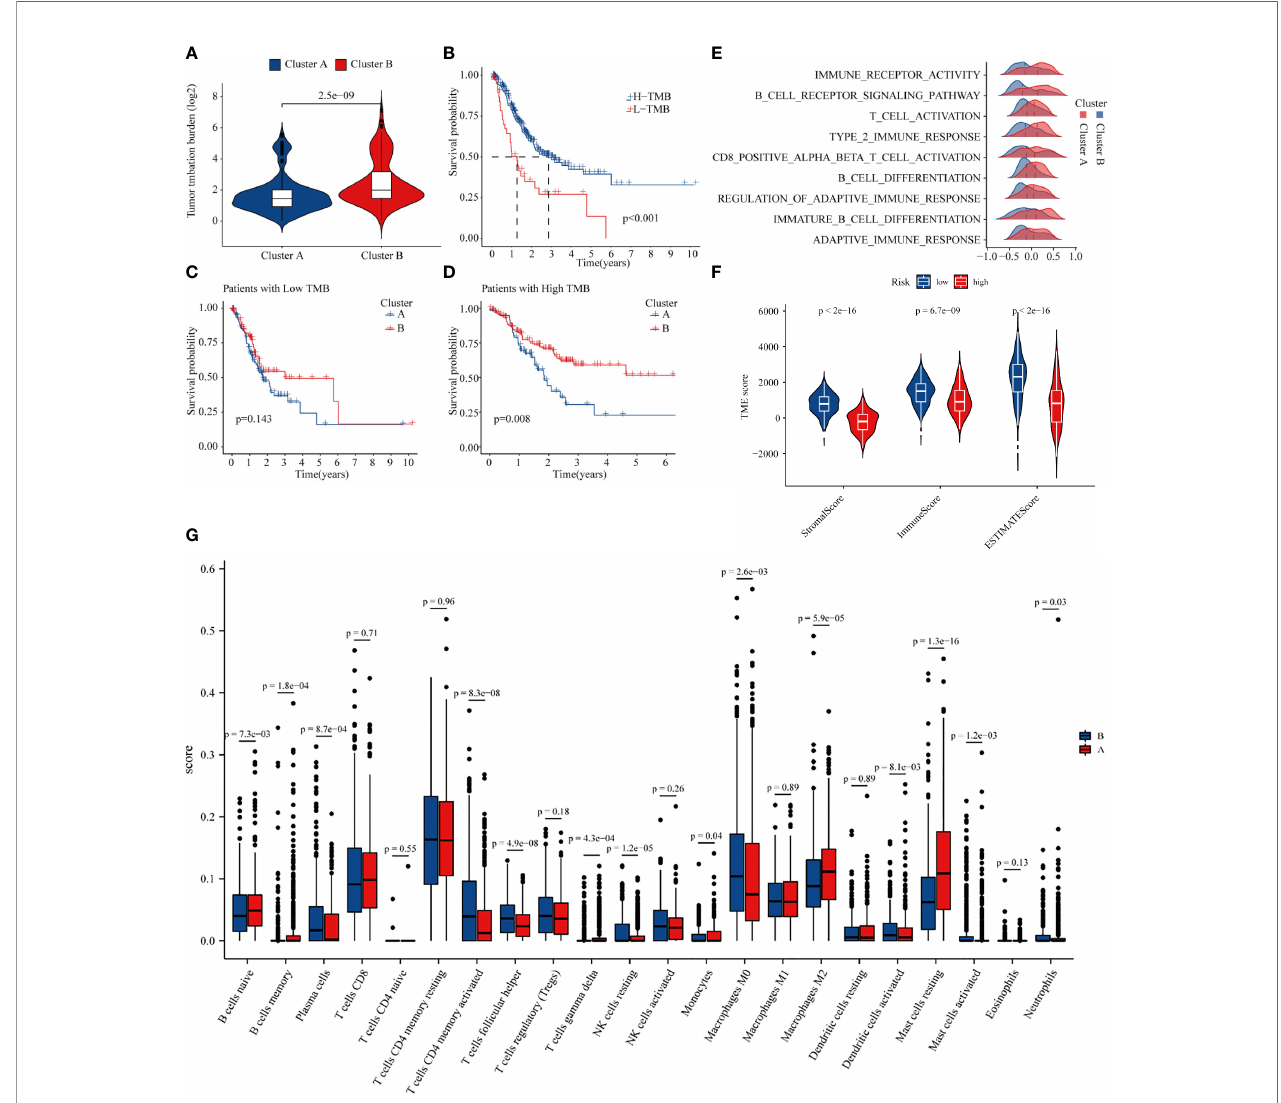
FIGURE 6 | Differences in tumor mutational burden and immune microenvironment in gastric cancer patients in different subtypes. (A) Tumor mutational burden of different GC subtypes. (B) Relationship between tumor mutational burden and prognosis of GC patients. (C, D) Prognosis of patients of high- and low-TMB in A or B GC subtpyes. (E) GSEA enrichment analysis of subtype. (F) Differences in the immune microenvironment in gastric cancer patients in different subtypes. (G) Differences in immune cell in fi ltration in different